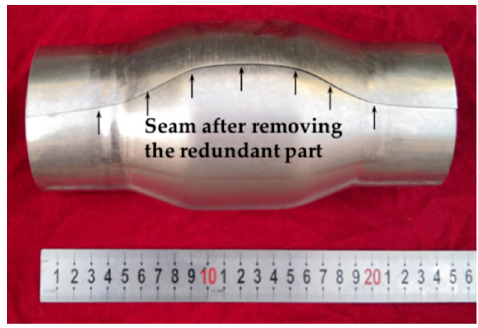
Figure 14. The final variable-diameter part.